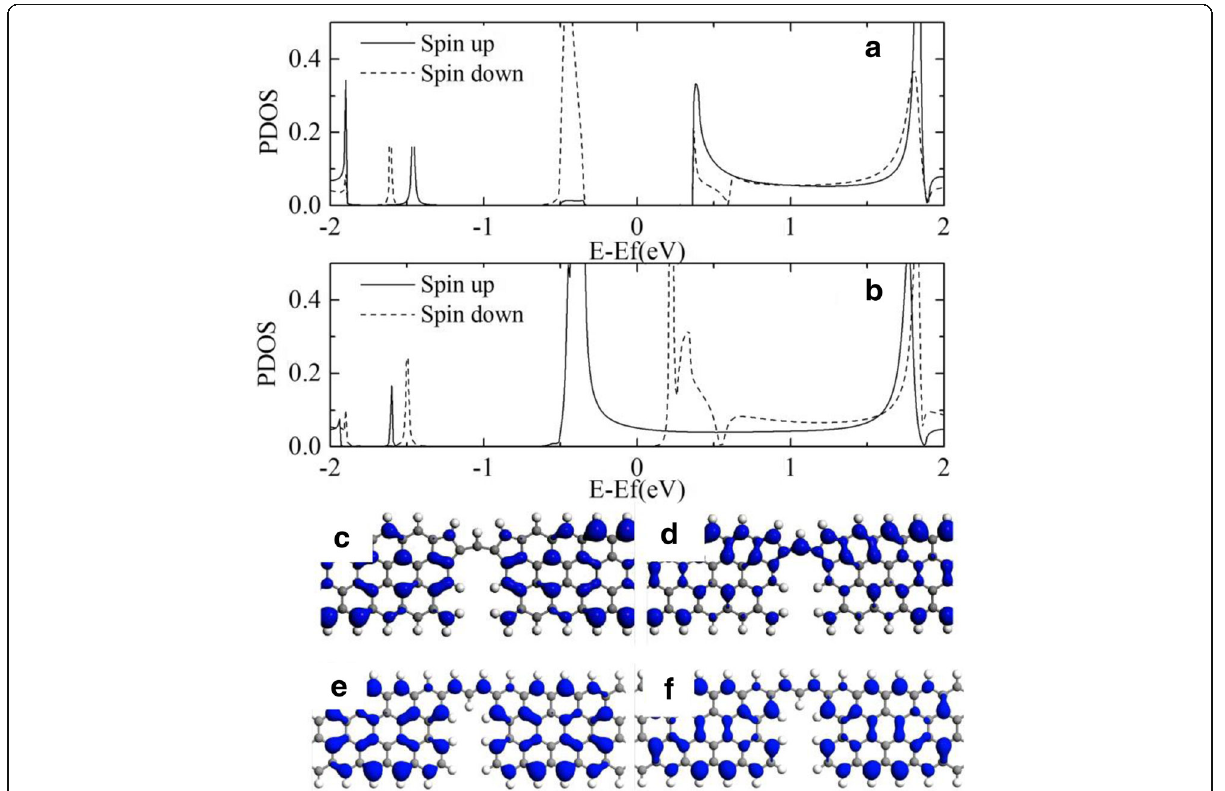
Fig. 5 The projected density of states on the bridge carbon atom of structure S1 at a [0,0] and b [1,1] configuration. c and d show the space resolved local density of states (LDOS) for spin down and spin up at the Fermi level at [1,1] configuration. e and f show the LDOS of structure S2 for